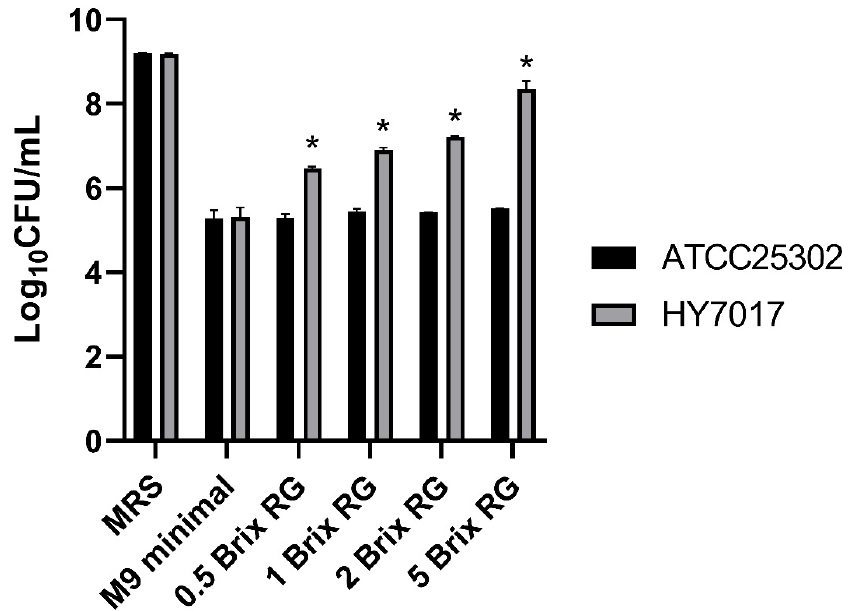
Figure 1. Bacterial numbers (log 10 CFU/mL) of Lactobacillus paracasei strains grown in MRS, M9 minimal medium, 0.5 Brix RG, 1 Brix RG, 2 Brix RG, and 5 Brix RG. Data are represented as mean ± standard error of the mean (SEM) of three independent experiments. * p < 0.05, compared with M9 minimal. MRS, cultured in MRS broth; M9 minimal, cultured in M9 minimal medium; 0.5 Brix RG, cultured in 0.5 Brix RGE broth; 1 Brix RG, cultured in 1 Brix RGE broth; 2 Brix RG, cultured in 2 Brix RGE broth; 5 Brix RG, cultured in 5 Brix RGE broth.